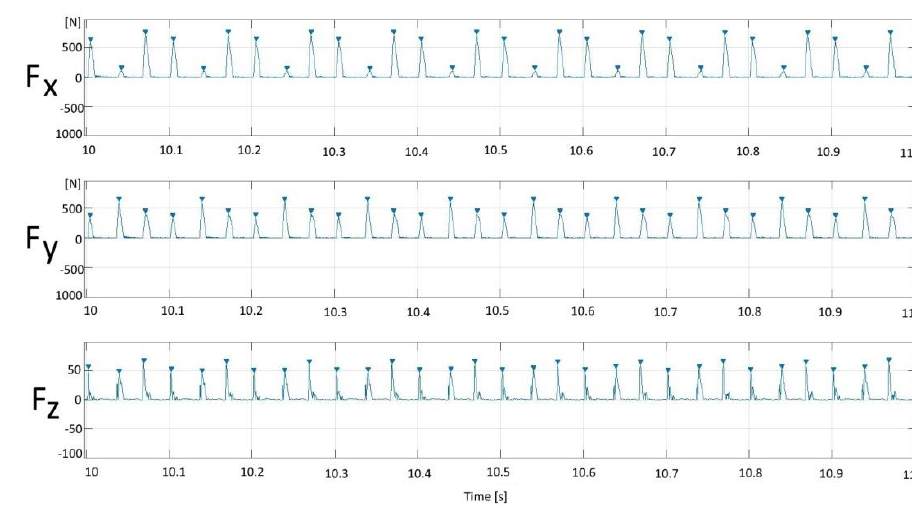
Figure 5. Typical dynamometer force readings.